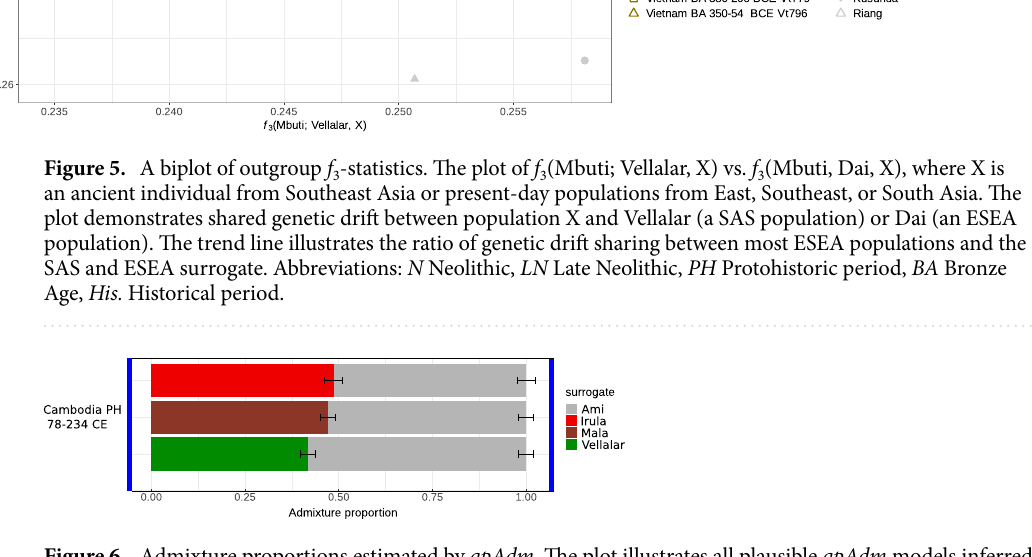
Figure 6. Admixture proportions estimated by qpAdm . The plot illustrates all plausible qpAdm models inferred using the rotating strategy (see details in “Materials and methods”). All the plausible models consist of two surrogates: (1) an East and Southeast Asian surrogate (Ami, on the right-hand side of each bar) and (2) a South Asian surrogate (Irula, Mala, and Vellalar on the left-hand side of each bar). Results for all qpWave and qpAdm models tested are available in Suppl. Table